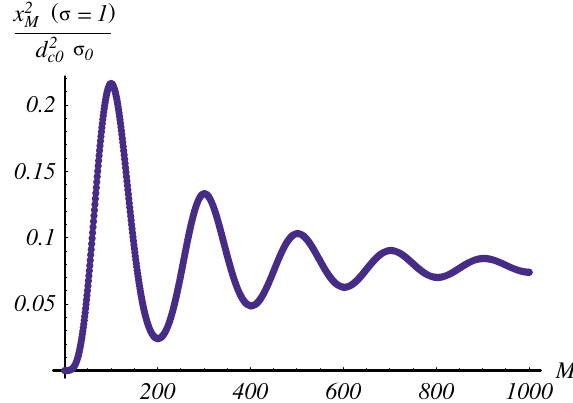
FIG. 5. (Color) Mean-square displacement along the accelera- tor for bunch M (cid:7) 500 (blue curve), M (cid:7) 600 (green curve), and M (cid:7) 1 (red curve). The parameters are the same as in Fig.